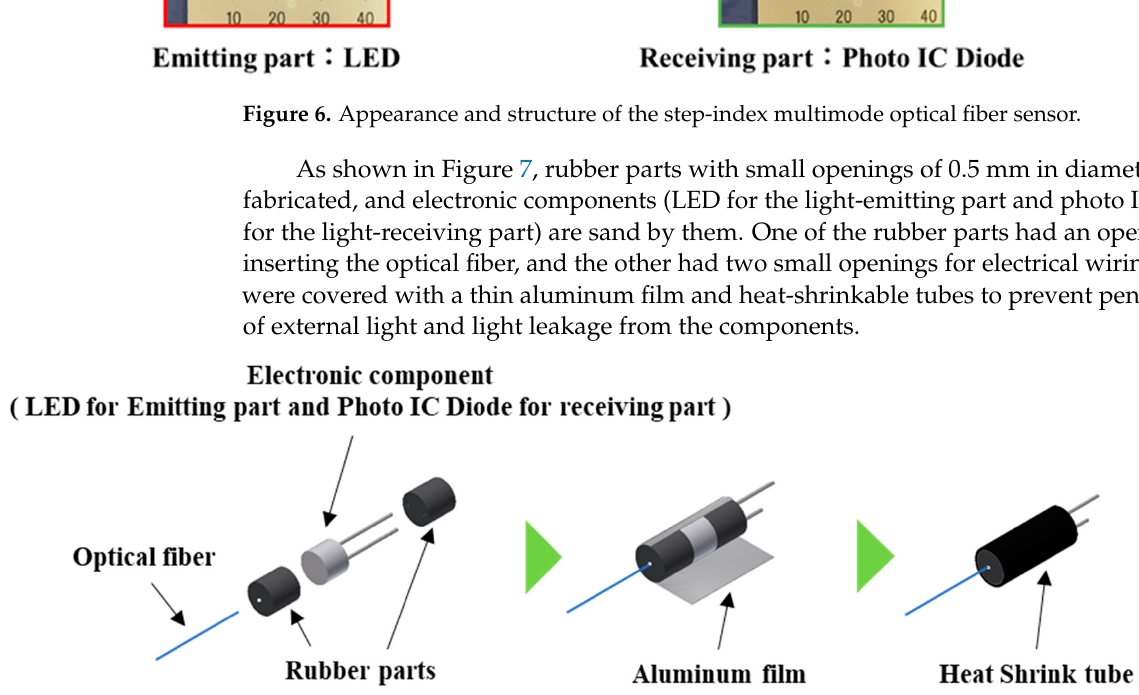
Figure 7. Structure of the emitting and receiving parts.